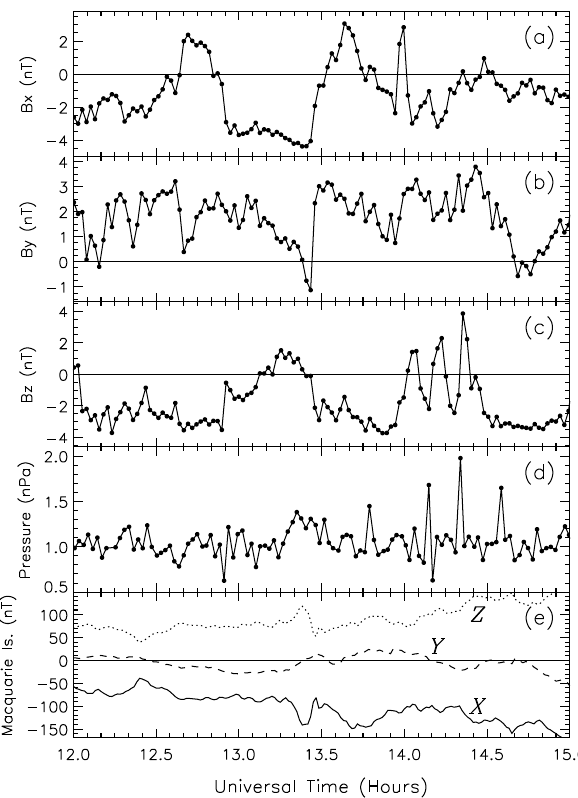
Fig. 1. Wind spacecraft measurements of the IMF (a) B x , (b) B y , and (c) B z components, and (d) the solar wind dynamic pressure, all averaged to ∼ 1.5min time resolution during 12:00 to 15:00UT on 10 December 1999. (e) Perturbations of the geomagnetic X (solid curve), Y (dashed curve), and Z (dotted curve) components measured at the Macquarie Island (MQI) magnetometer (provided courtesy of the Australian Geological Survey Organisation). The abscissas have tick marks at 5min intervals of